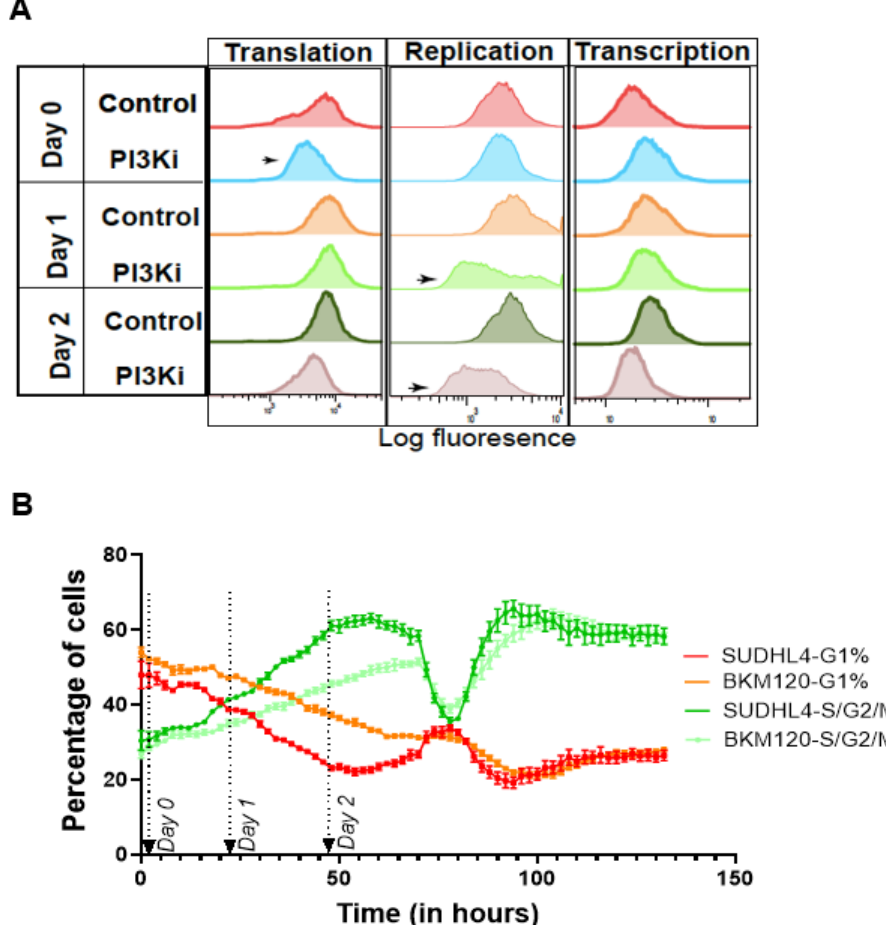
Figure 7. SUDHL4 cells treated with BKM120 recapitulate the predicted biological sequence of responses. ( A ) Histograms represent global transcriptional, replication, and translational activity measured in SUDHL4 cells pre-treated and released from BKM120 (1 µ M) and quantified as intensity (x-axis) on indicated days using fluorescently labeled Click-IT substrates. ( B ) Line graph shows changes in cell cycle pattern in SUDHL-4 cells transfected with fluorescently labelled cell cycle indicator, represented as percentage of cells in G1, S-G2-M cells and time, following BKM120 release.